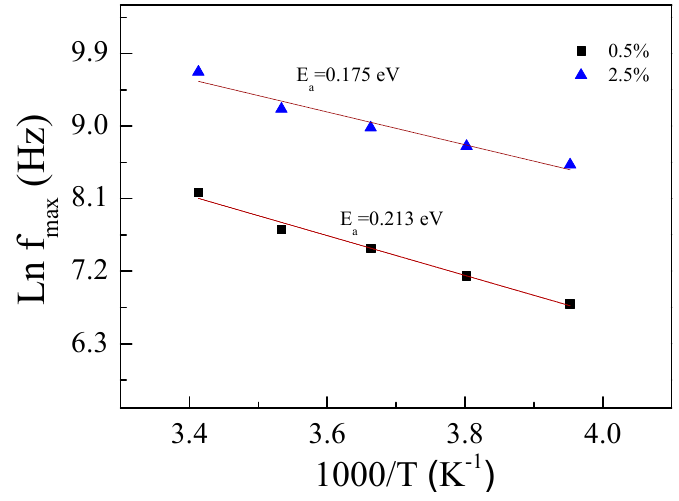
Figure 8. Arrhenius plots of the dielectric relaxation process for 0.5% and 2.5% ZNTO ceramics.